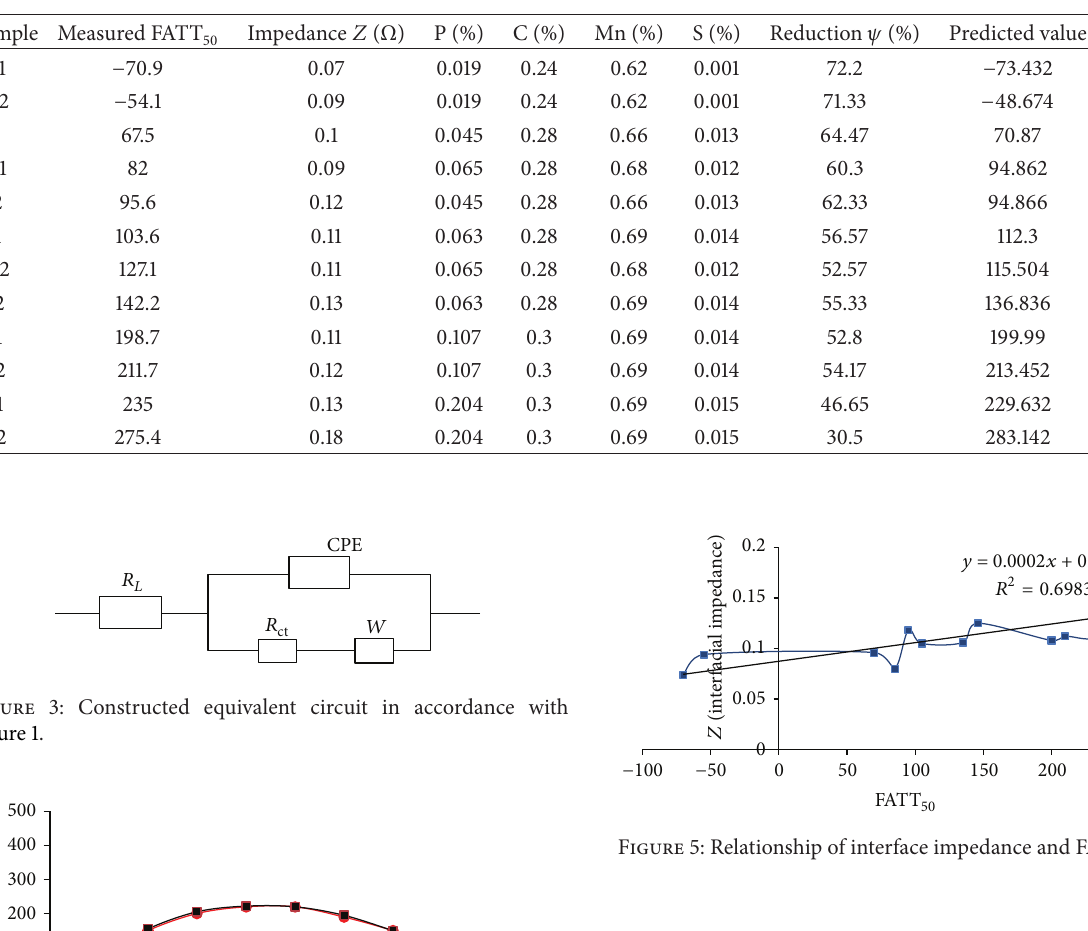
includes two parts: solution impedance between working electrode and auxiliary electrode and interfacial impedance between the rotor and electrolyte. At higher frequency, there is a linear relationship between the interfacial impedance and its FATT 50 . The larger the interfacial impedance value, the lower the FATT 50 . An effective predictive model could